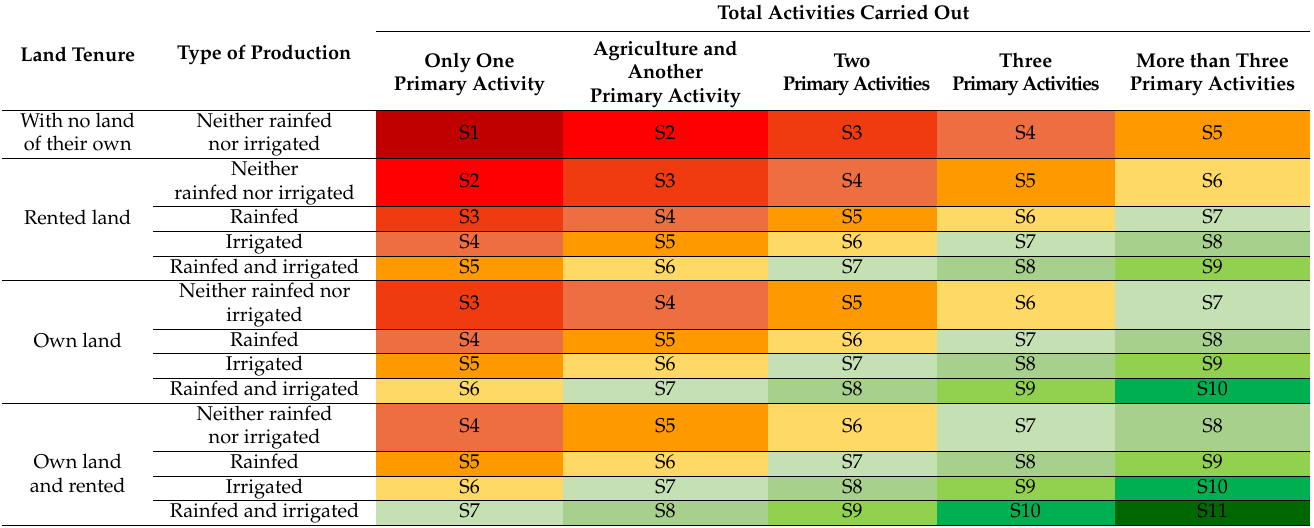
Table 2. Classification of eleven producer sensitivity levels.